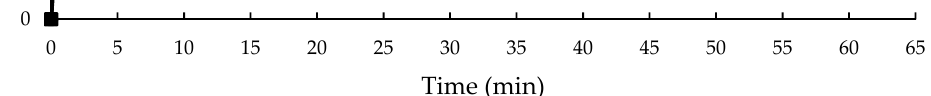
Table6. TheantibacterialactivityofpectinfilmscontainingclindamycinHClagainst Staphylococcusaureus and Cutibacterium